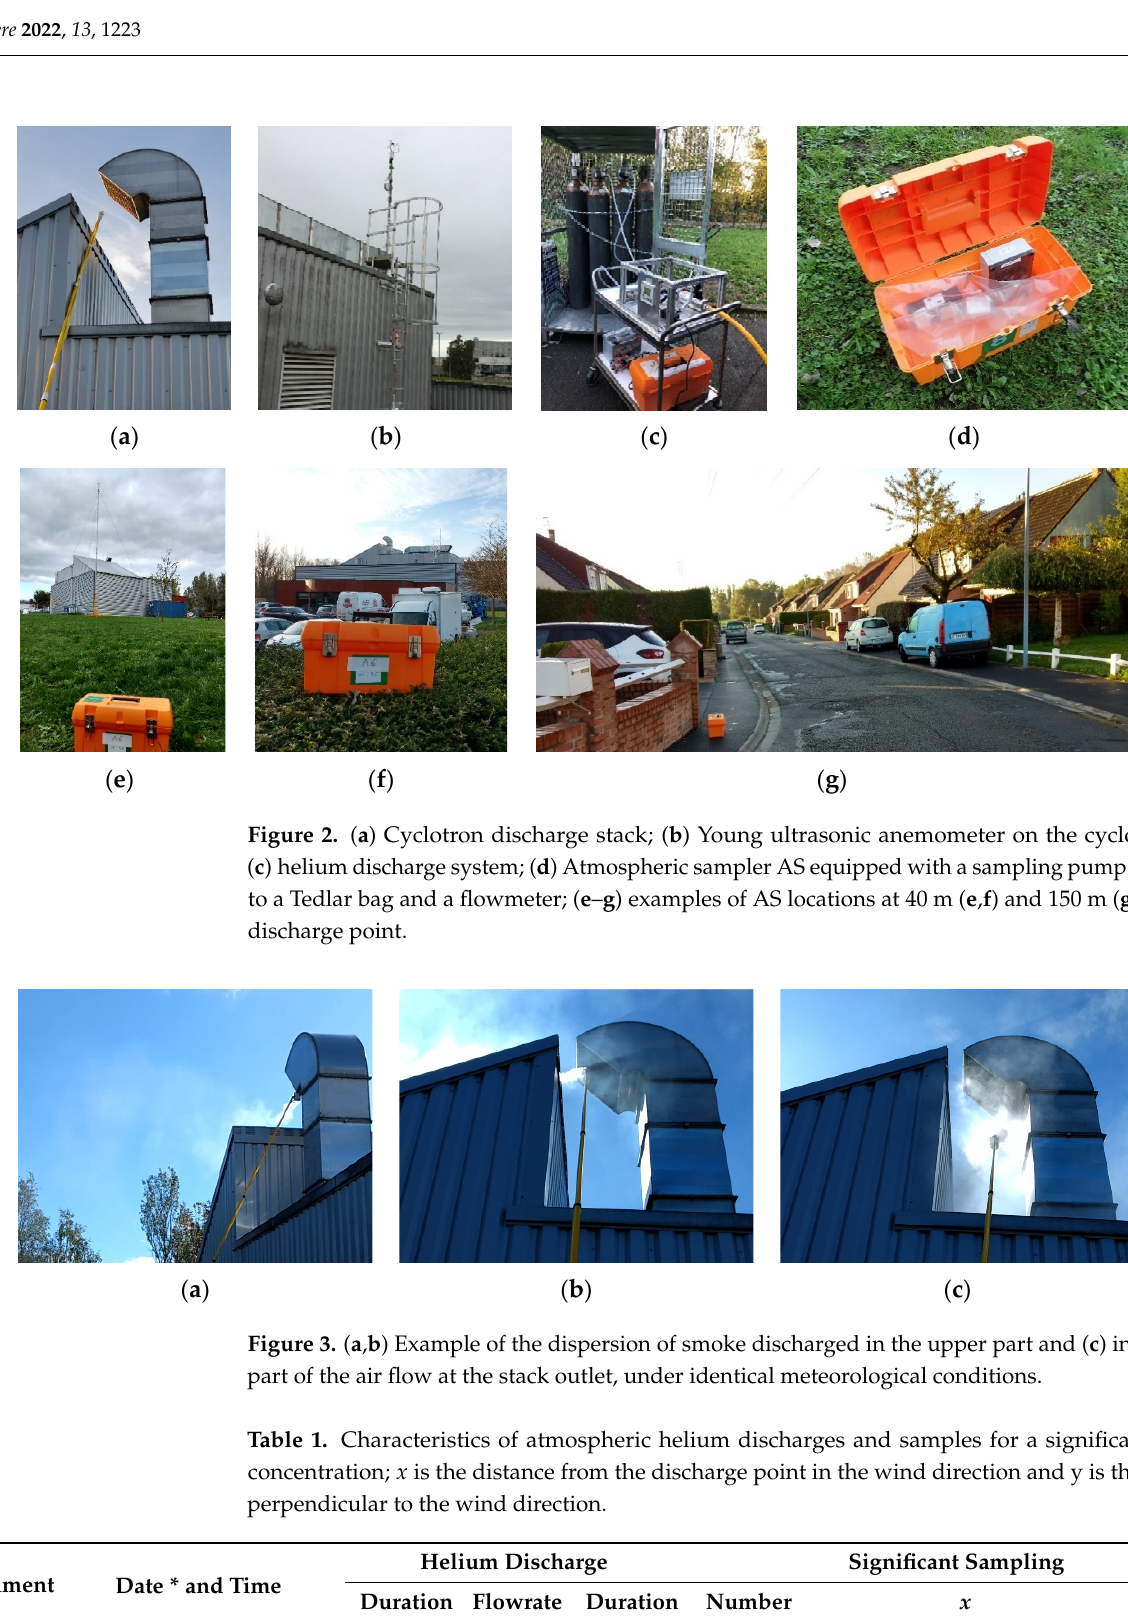
Table 1. Characteristics of atmospheric helium discharges and samples for a significant helium con-